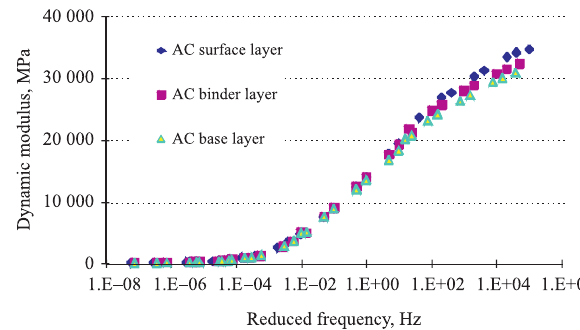
Fig. 6. Dynamic modulus at 10 °C reference